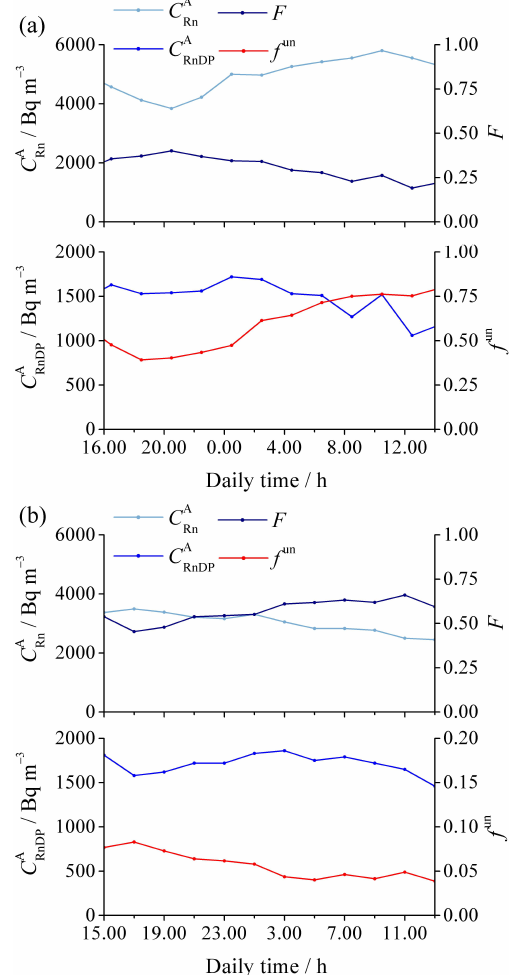
Fig. 4. Results of continuous radon measurement at the lowest point in the Postojna Cave (a) in summer 2009 and (b) in win- ter 2010: radon activity concentration ( C A tween radon and its decay products ( F ), equilibrium-equivalent ac- tivity concentration of radon decay products ( C A of unattached decay products ( f un